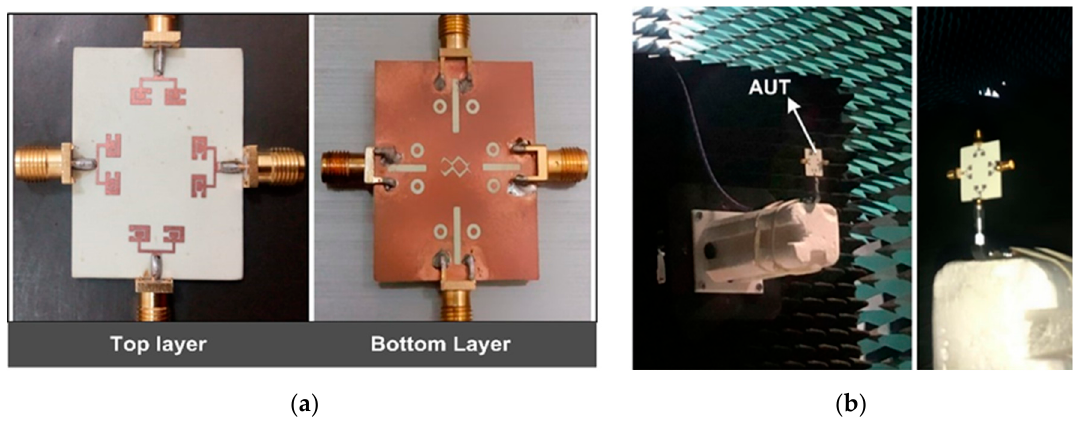
Figure 6. ( a ) Fabricated antenna module ( b ) antenna module in measurement.